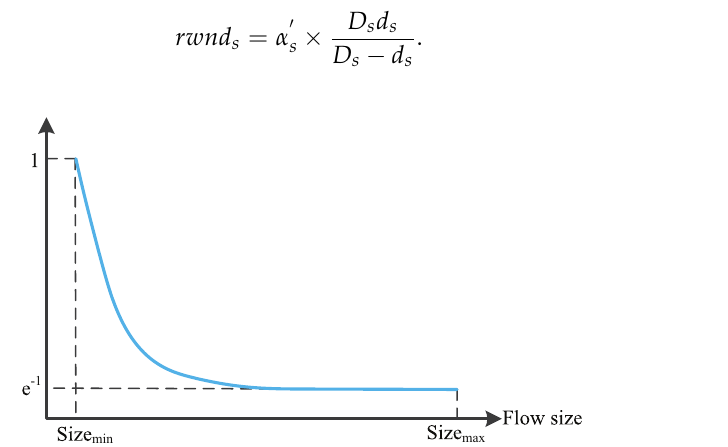
Figure 4. The range of the exponential function used in Equation (12) for the calculation of receive window